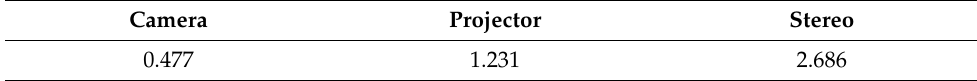
Table 1. RMS reprojection errors of the first configuration.